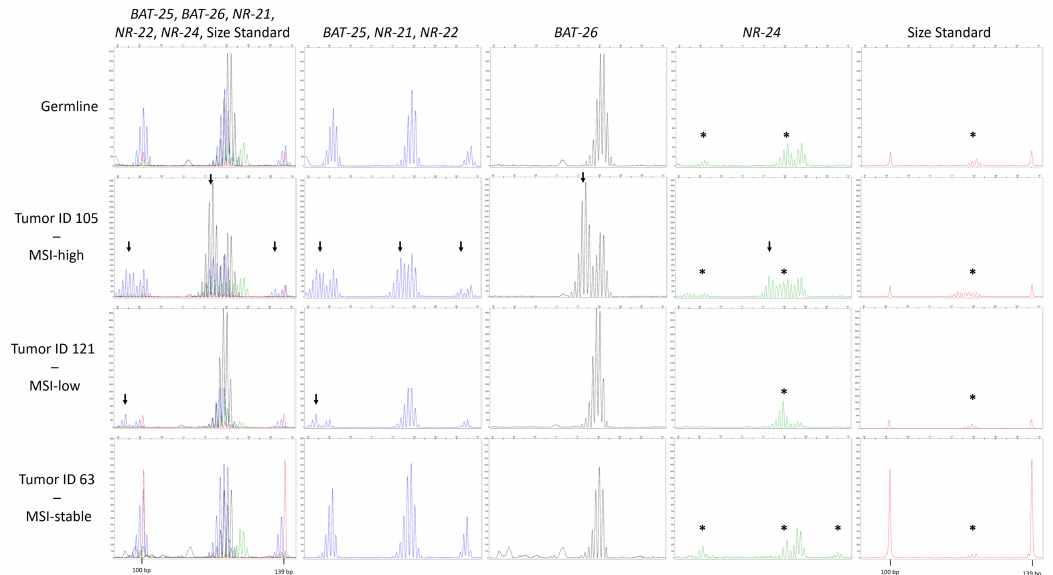
Figure 3. Typical allelic profiles of BAT-25, BAT-26, NR-21, NR-22, and NR-24. Only the range from 92 to 142 bp of the electropherograms comprising the region of interest is shown. The red line indicates the GeneScan 350 ROX TM dye Size Standard labeled with ROX displaying the 100 bp and 139 bp peak. The first column shows all traces, the second column shows the fluorescein (FAM)-labeled products ( BAT-25 , NR-21 , and NR-22 ) depicted in blue. In the third column, the ATTO55O-labeled BAT-26 is separately displayed in black. HEX-labeled NR-24 is shown separately in green in column 4, and the fifth column shows the size standard in red. The expected sizes for the products NR-21 , BAT-25 , BAT-26 , NR-24 , and NR-22 were 99, 123, 124, 128, and 139 bp, respectively. The top panel shows the normal germline alleles with typical stutter bands. In the lower panels, the electropherograms of the only microsatellite instability (MSI)-high tumor sample (ID 105), the only MSI-low tumor sample (ID 121), and one MSI-stable tumor sample (ID 63) is shown. The arrows indicate the presence of shifted alleles. The asterisk depicts artifacts coming from bleed-trough from the FAM signal into the other signals, identifiable by peaks in the other colors occurring at the exact same size as the FAM